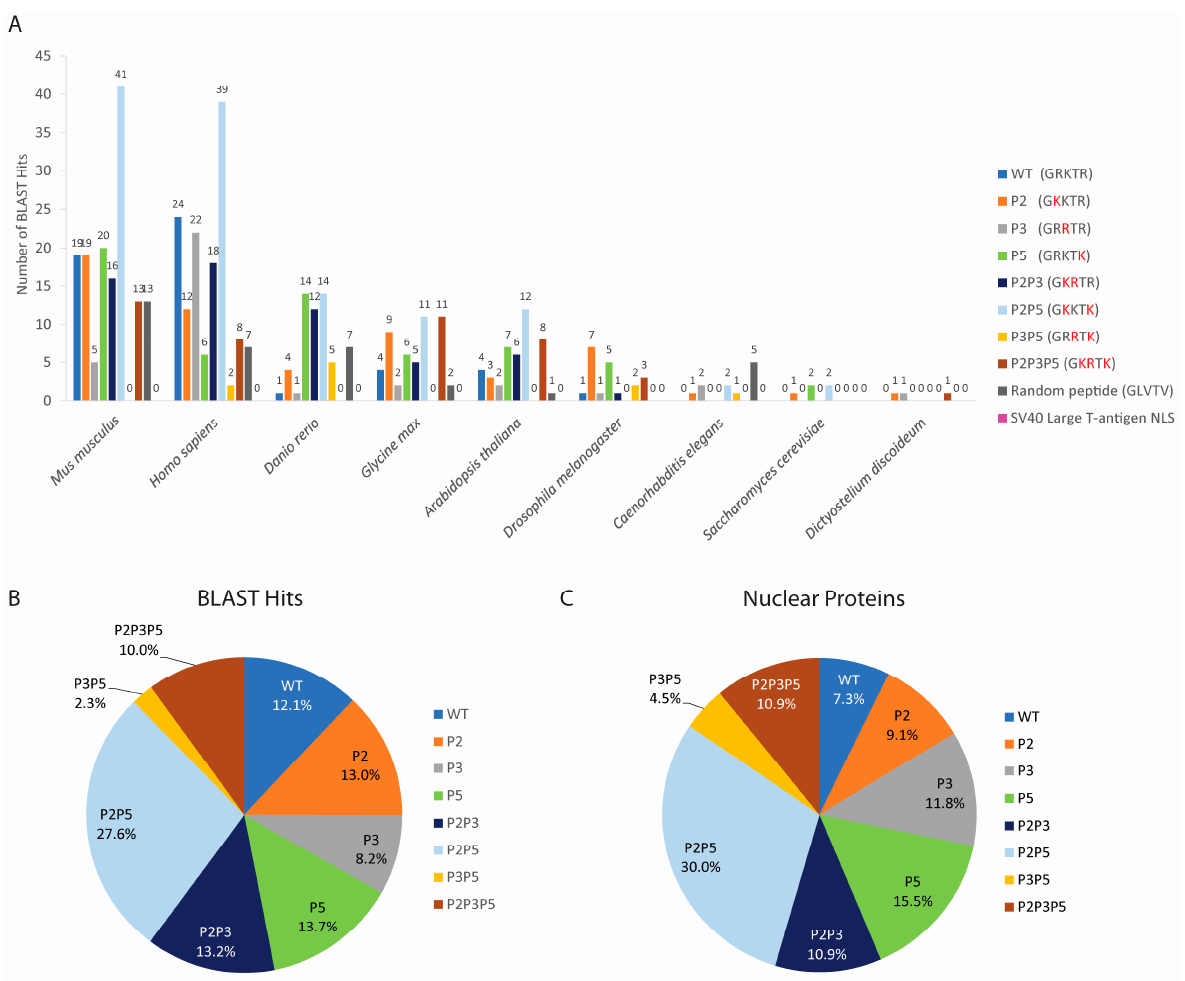
Figure 5. Bioinformatics of the sequence GRKTR and its variants for nuclear proteins. ( A ) The sequence GRKTR and its variants (listed in Table 2), the control peptide GLVTV, and the SV40 large T-antigen NLS were entered into the BLASTP algorithm. Only the number of hits for proteins that are known to localize in the nucleus of cells from humans and several model organisms is reported. The amino acids in red indicate substitutions from the WT NLS2. ( B ) Percentage of BLAST hits for nuclear proteins containing each of the studied sequences. ( C ) Percentage of nuclear proteins containing each of the studied sequences.